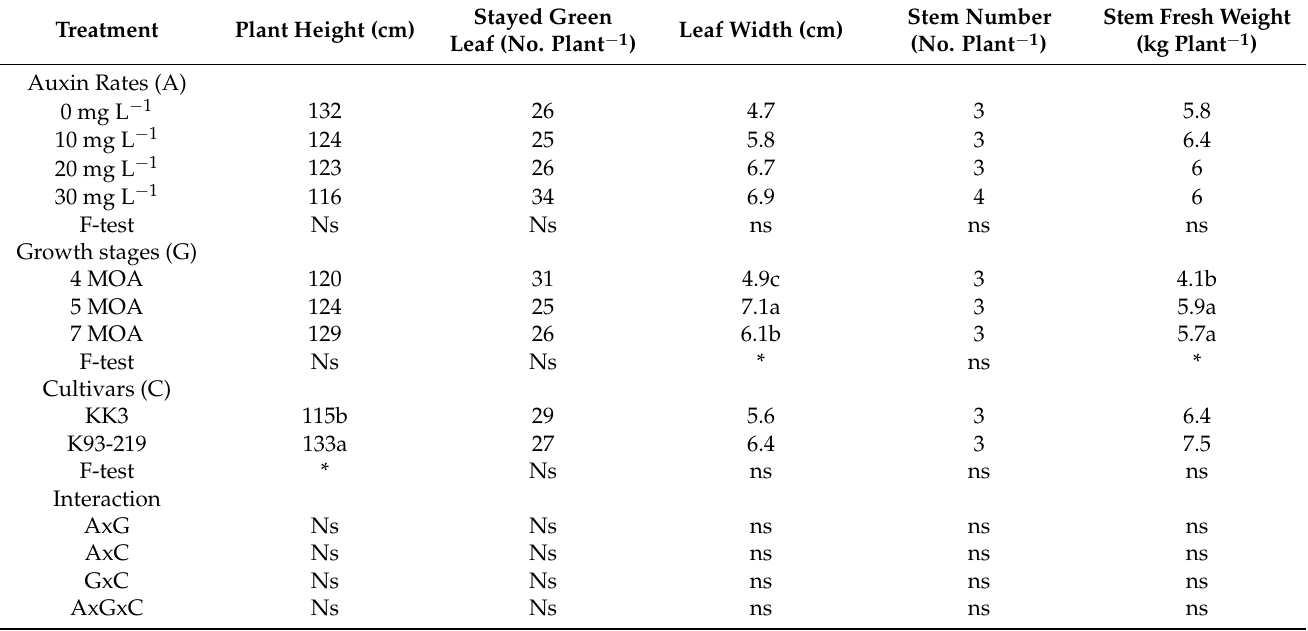
Table 10. Growth parameters of two sugarcane cultivars as affected by auxin application rates at different growth stages at harvest, Experiment